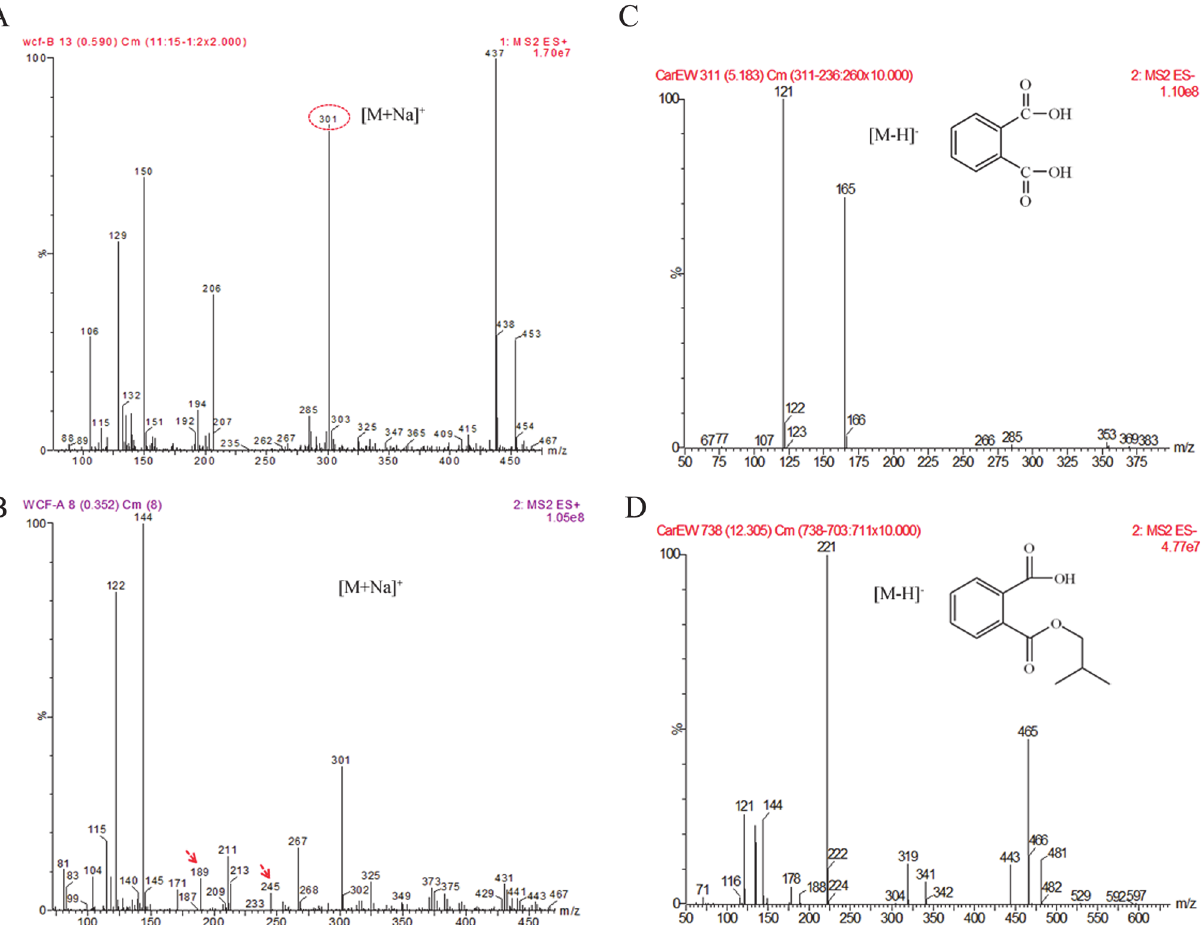
Fig 5. ESI-MS analysis of products identified in the CarEW catalyzed reaction. (A) and (B) The full ion scan of DiBP degradation after incubation with CarEW and the control without CarEW. m/z 301, DiBP; DiBP incubation with CarEW. m/z 189, PTH; m/z 245, MiBP. (A) and (B) were both tested under the positive mode ([M+Na] + ). (C) and (D) Daughter ion scan for metabolites derived from the biodegradation of DiBP. (C) m/z 121, phthalate acid (PTH); (D) m/z 221, monoisobutyl phthalate (MiBP). Both were tested under negative mode ([M-H] −